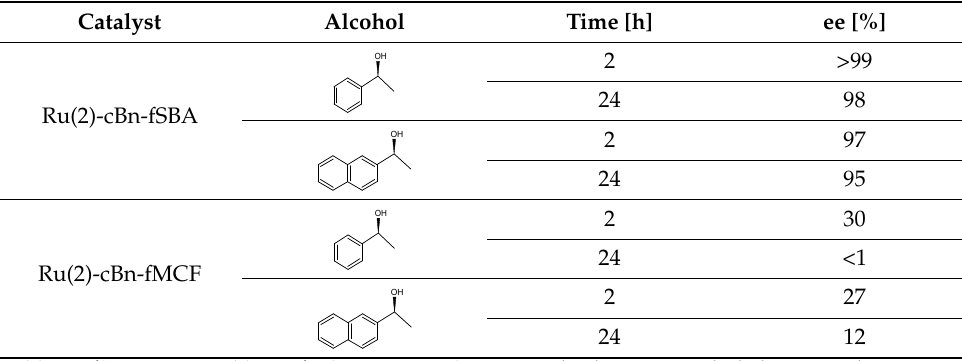
Table 5. Comparison of the activity of immobilized catalysts on MCF and SBA-15. Catalyst